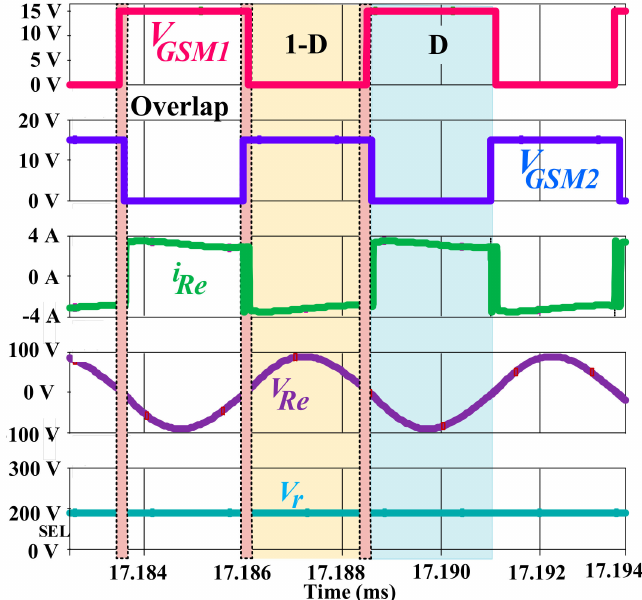
Figure 7. Waveforms of the DC-DC resonant converter: gate-signals ( V GSM 1 and V GSM 2 ), input voltage, and current at the resonant tank ( i Re and V Re ) and output voltage ( V r